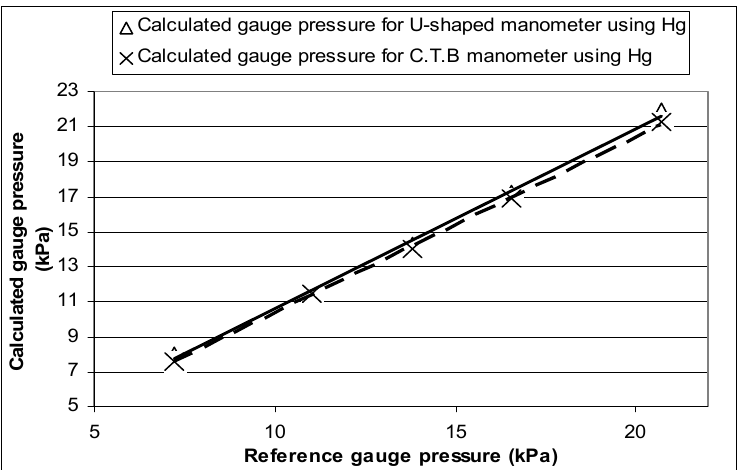
Figure 13 . Comparison of measured gauge pressure with calculated gauge pressures using